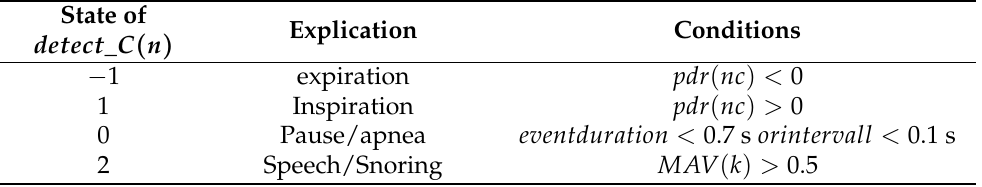
Table 3. Cardiac detection (phonocardiogram (PCG)-derived respiration (PDR)) stats.